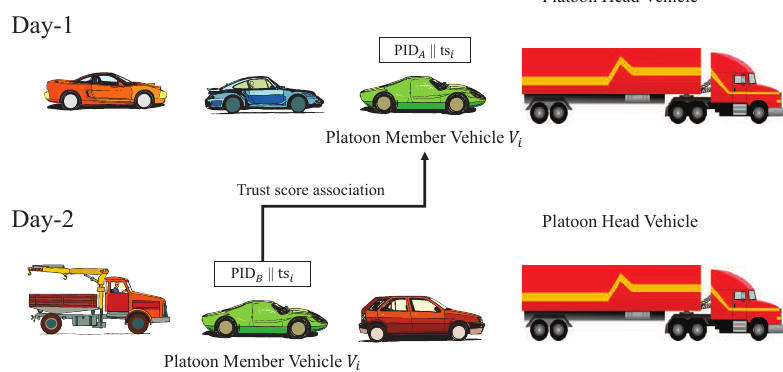
Figure 1. Platoon head vehicle associates a platoon member vehicle’s trust scores even when its pseudonym has been